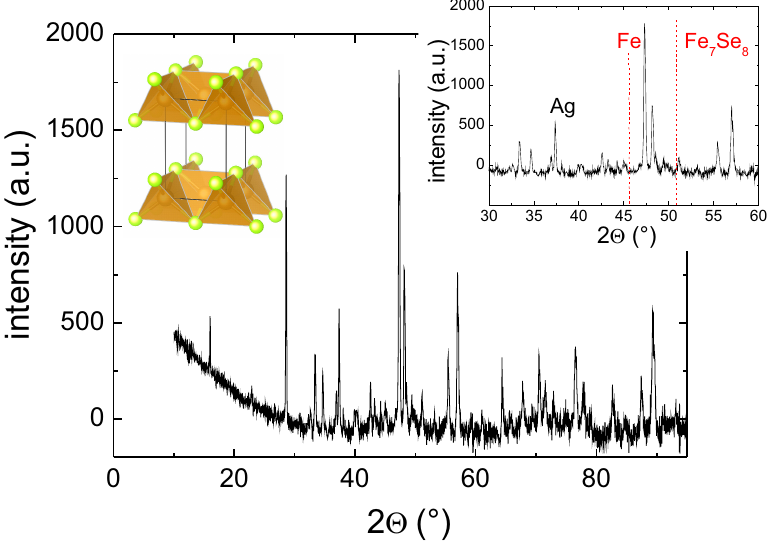
Figure 3. X-ray 2 Θ -scan for the sample of 4 wt.% Ag. The left inset gives the crystal structure of β -FeSe, and the right inset shows the peaks at 44.73 ◦ and 50 ◦ , where pure Fe and the Fe 7 Se 8 contribution can be identified following